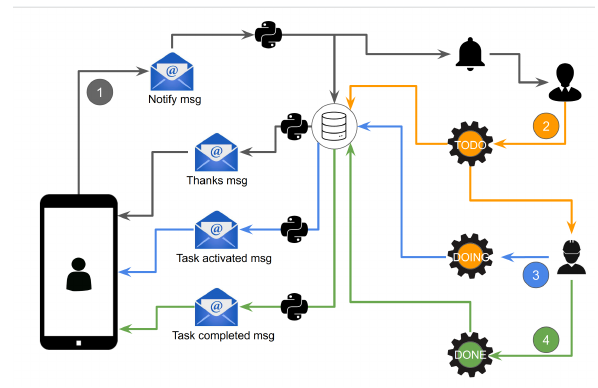
Figure 8. Web interface of the Park Assets Management (PAM) platform.